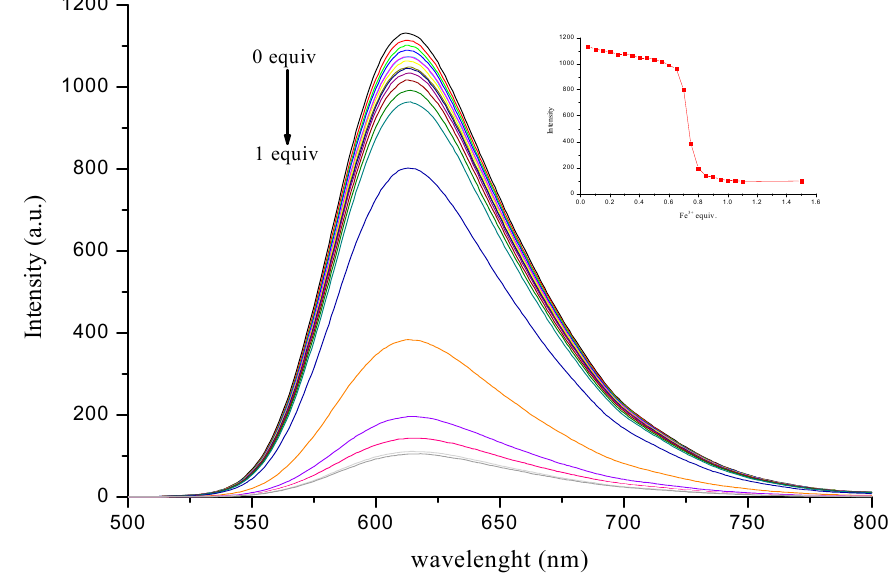
Figure 6. Emission spectra of the complex [{Ru(bpy) 2 } 2 ( µ 2 -H 2 L)](PF 6 ) 4 (10 − 5 mol / L in CH 3 CN / H 2 O = 1:1, v / v , excitation wavelength = 450 nm) upon the addition of Fe(ClO 4 ) 3 (0–1.6 equiv.) at room temperature; the plot of emission intensity at 612 nm vs. the added Fe 3 + equivalents is shown in the inset.